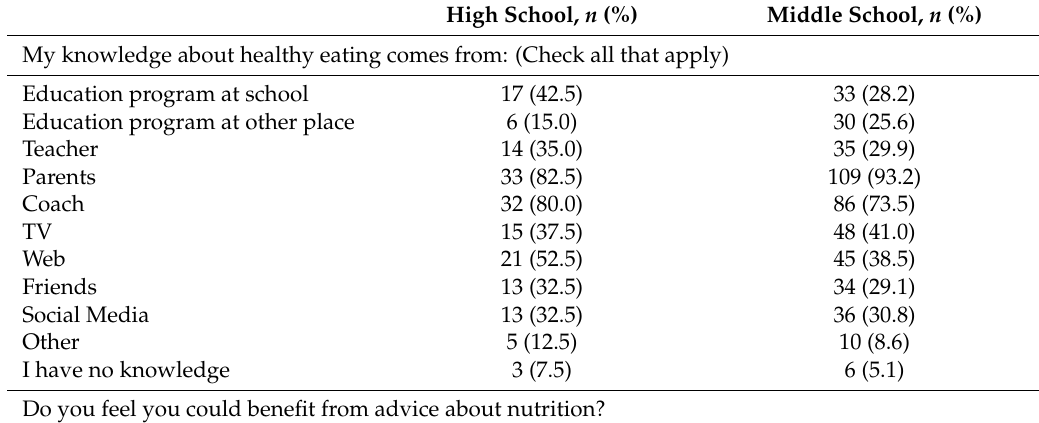
Table 2. Current sources of nutrition information and interest in learning about nutrition. High School, n (%) Middle School, n